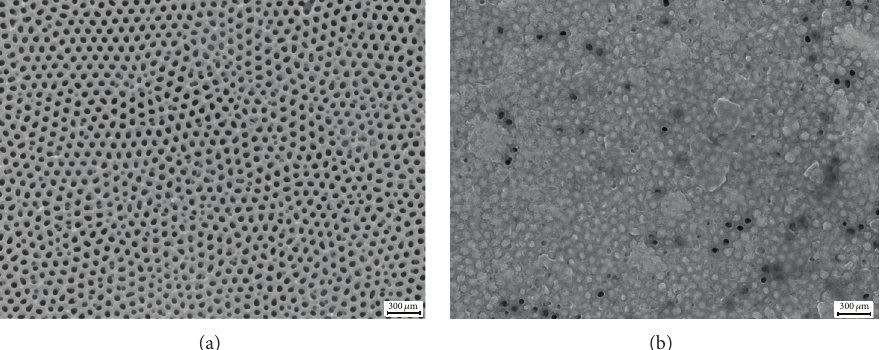
Figure 2: SEM images: (a) a porous alumina membrane with an ordering pore diameter of 80nm and (b) zinc aluminum nanowire arrays fabricated in the alumina nanomold by the vacuum die casting